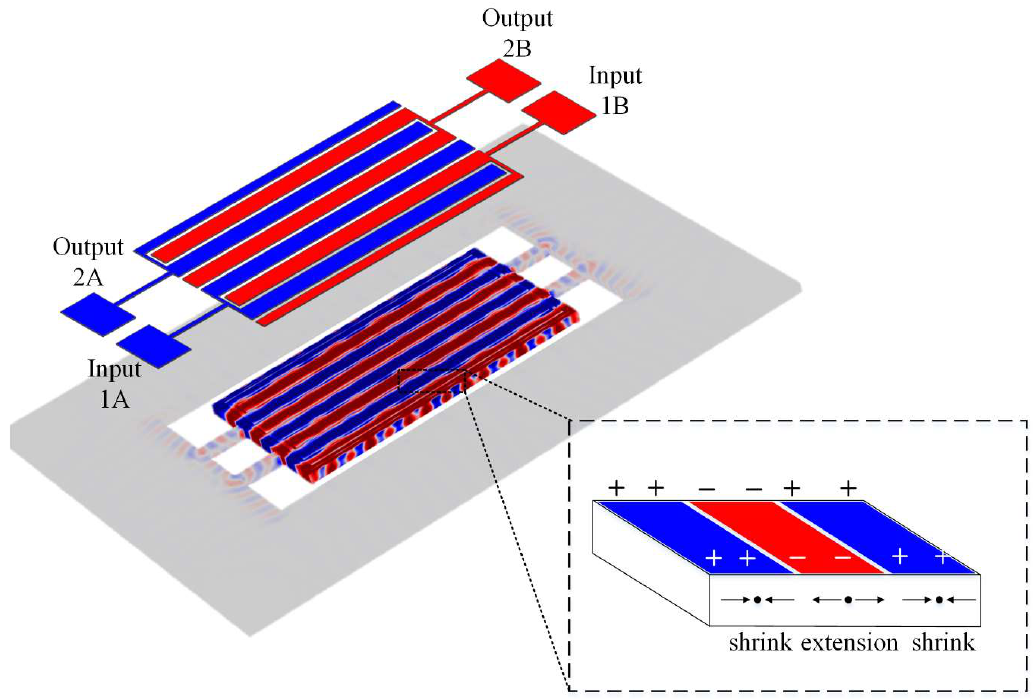
Figure 4. Illustration showing the volumetric strain profile of the 8th-order width-extensional vibration mode resonator. The distribution of strain polarities corresponds to that of displacement. The number of order is even. Insert provides the polarity and distribution of charge for this mode. Electrodes with the same amount were positioned on the corresponding strain regions. This DIDO configuration required a specific distribution of electrodes. All the electrodes were divided into two groups depending on the strain polarity of the region where they were positioned (i.e., group A and group B). So the polarities of these two groups were opposite. The electrodes on the same strain polarity regions were grouped together and then divided into input electrode and output electrode (e.g., 1A and 2A). Due to the specific distribution of these electrodes, when di ff erential signals were applied to the input side, the proposed resonator operating in the DIDO configuration should output two anti-phase